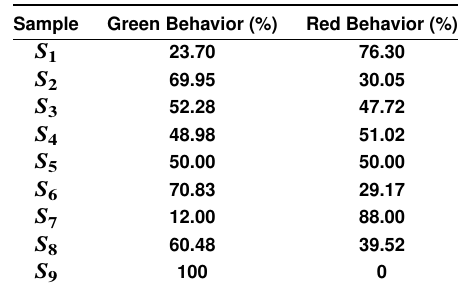
Table 3. Sample Datasets, S